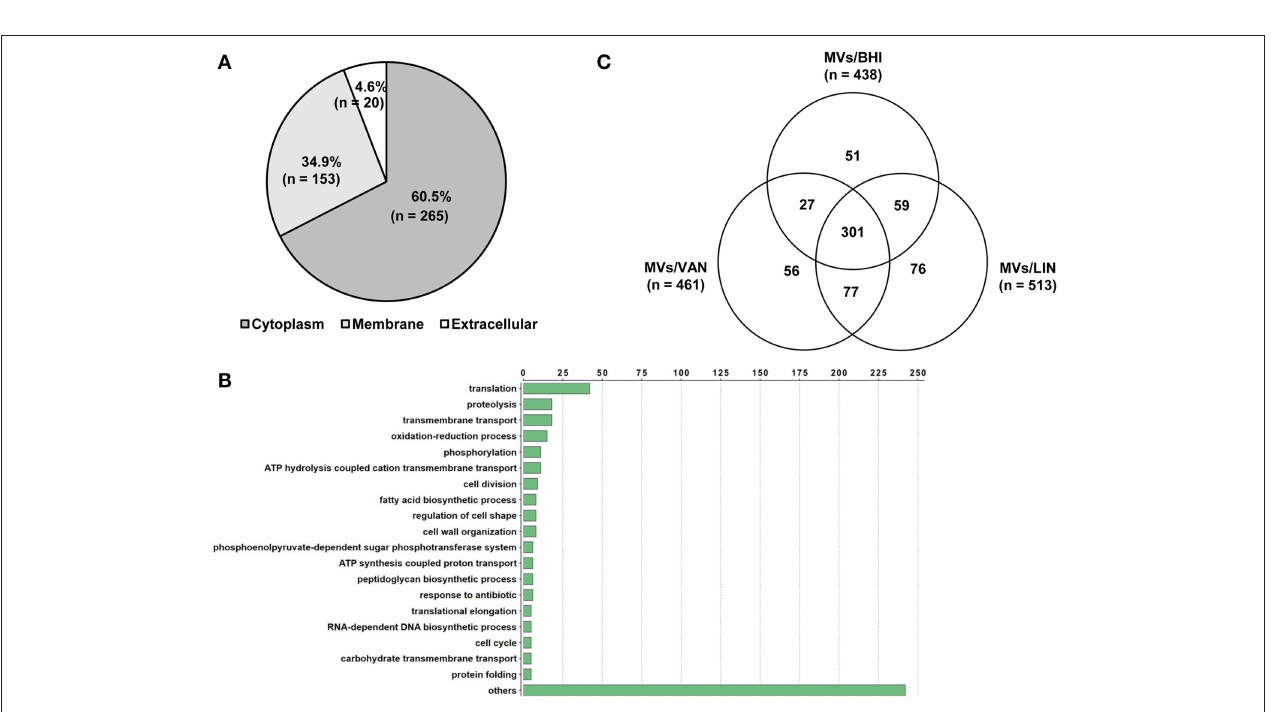
FIGURE 2 | Proteomic analysis of MVs produced by E. faecium ATCC 700221. MVs were isolated from E. faecium cultured in BHI broth (MVs/BHI), BHI broth with 256 µ g/ml vancomycin (MVs/VAN), or BHI broth with 1 µ g/ml linezolid (MVs/LIN). (A,B) A total of 438 proteins in the MVs/BHI were analyzed based on cellular localization (A) and Gene Ontology (B) . (C) A Venn diagram of proteins identified in the MVs/BHI, MVs/VAN, and MVs/LIN.